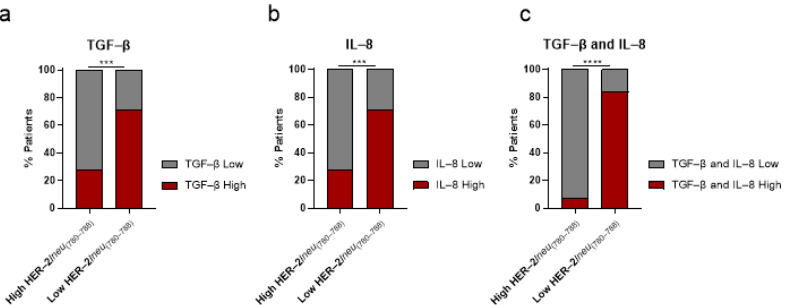
Figure 4. Percentages of prostate cancer (PCa) patients with high vs. low frequencies of HER- 2/ neu (780–788) -specific CD8+ T lymphocytes in association with high vs. low levels of ( a ) transforming growth factor beta (TGF- β ), ( b ) interleukin-8 (IL-8), or ( c ) both. *** p < 0.001; **** p < 0.0001.